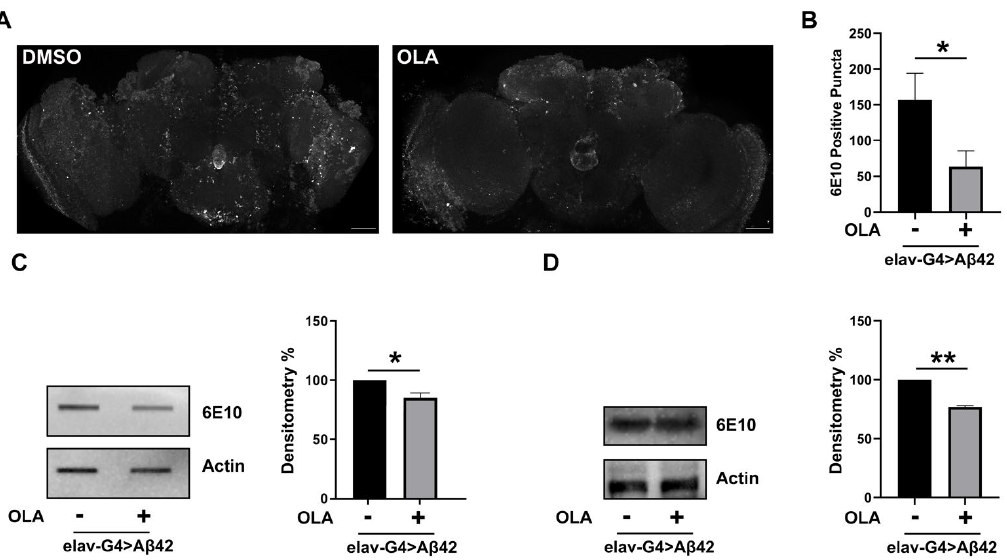
Figure 6. ( A ) Confocal images of representative fly brains from 15-day-old elav-Gal4 > A β42 flies raised on standard medium supplemented with DMSO or olaparib showing immunoreactivity to anti-amyloid- β antibody (6E10). Scale bar indicates 50 μm. ( B ) Histogram depicts the quantification of 6E10-positive puncta. n = 6 adult brains. Error bars represent SEM. (* p < 0.05). ( C ) and ( D ) Slot and Western blot analysis of brain protein extracts from elav-Gal4 > A β42 flies probed with Aβ42 specific antibody (6E10) (left panel). Quantification (right panel) was made using Actin for normalization and results are expressed as percentage relative to levels measured in vehicle-treated elav-Gal4 > A β42 flies. Statistical significance was determined by unpaired t - test (* p < 0.05, ** p < 0.01).